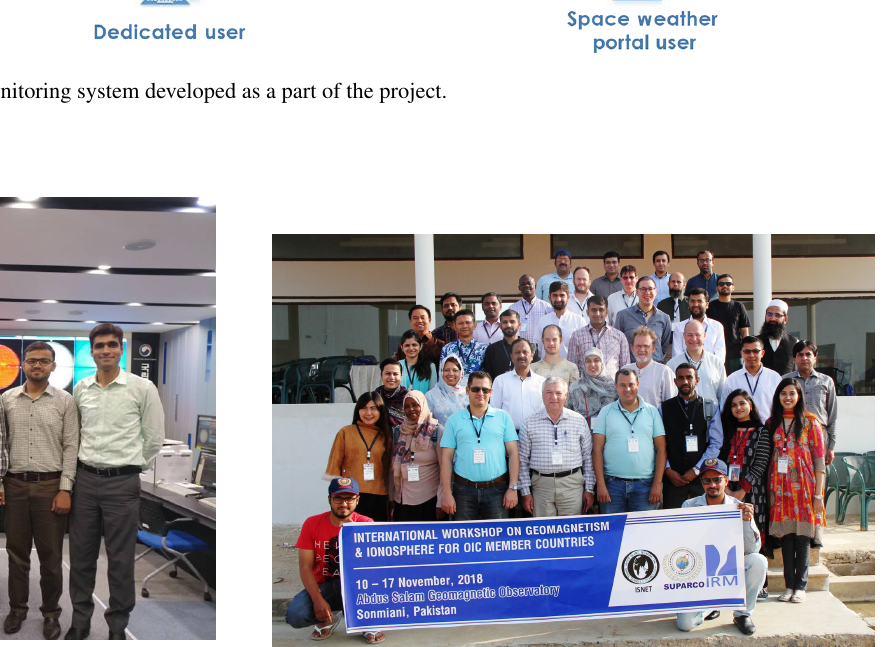
Figure 15. Participants of the